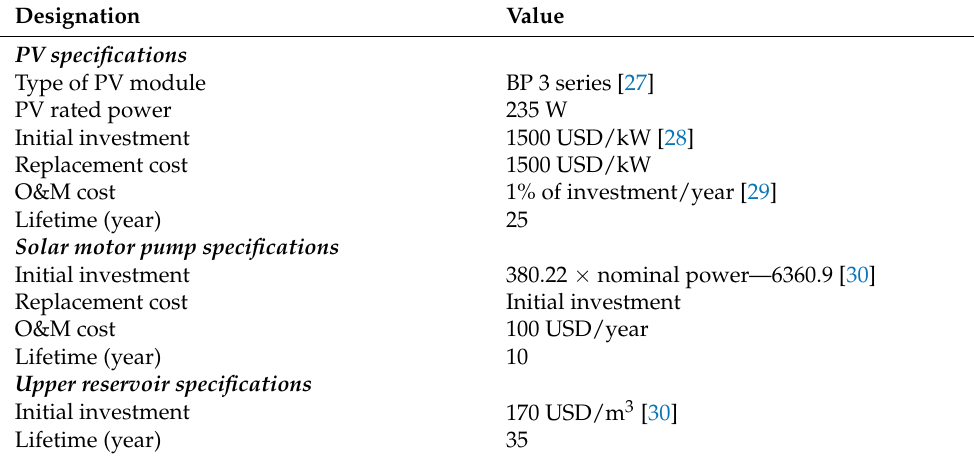
Table 1. Parameter specifications used for